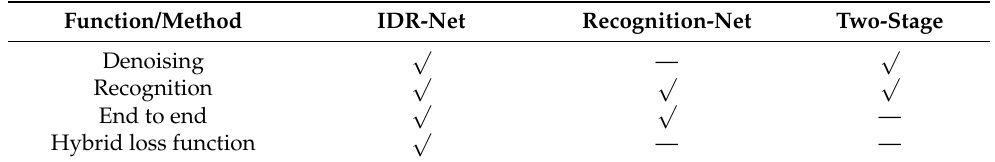
Table 6. Configurations of the three models.